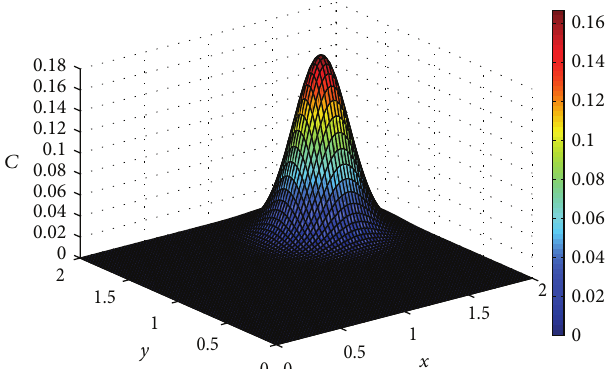
Figure 4: The RK4-CD6 solution of Example 2 with Δ𝑡 = 0.0125 , ℎ = 0.025 , 𝐷 𝑥 = 𝐷 𝑦 = 0.01 , and 𝑡 = 1.25 for 0 < 𝑥 , 𝑦 < 2 .